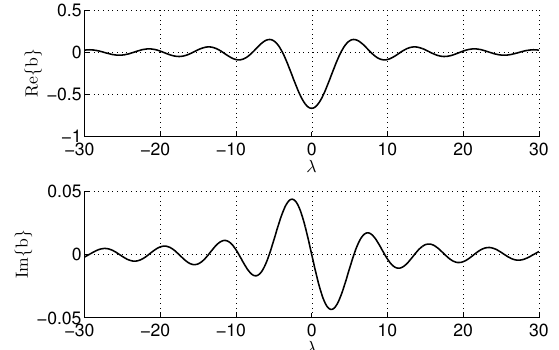
Figure 2. Real and imaginary parts of a ( λ ) .